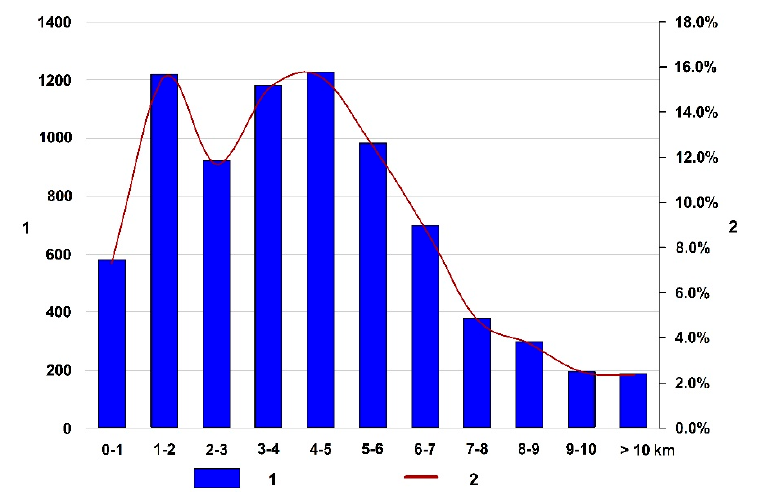
Figure 3. The number of industrial entities and their share in total depending on the distance from the city center in 2016 (sourced by authors). Explanations: 1—number of entities; 2—participation of entities.